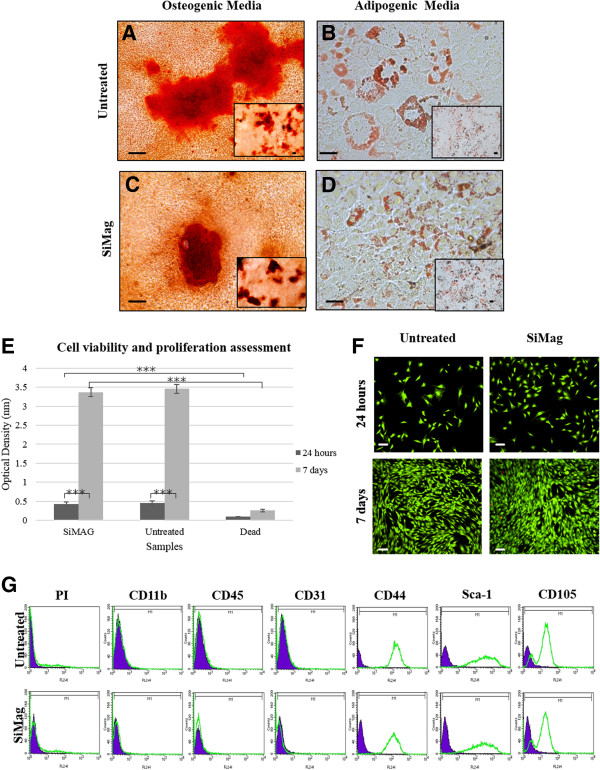
Immunophenotypic characterization, cell viability, proliferation and differentiation of SiMAG-labelled mMSCS. mMSCs labelled with (C, D) and without (A, B) SiMAG underwent successful differentiation down osteogenic (A, C) and adipogenic (B, D) lineages after 21 days. mMSCs labelled with 10 μg/ml of SiMAG characterised at 24 hours and 7 days by E) MTT analysis and F) live dead staining. *** Indicates P <0.001. Bars = 100 μm. (G) SiMAG-labelled and unlabelled mMSCs were negative for hematopoietic markers CD11b and CD45, endothelial cell marker CD31 and positive for CD44, CD105and Sca-1. The expression of every antigen is shown together with their corresponding isotype control. mMSCs, murine mesenchymal stem cells.